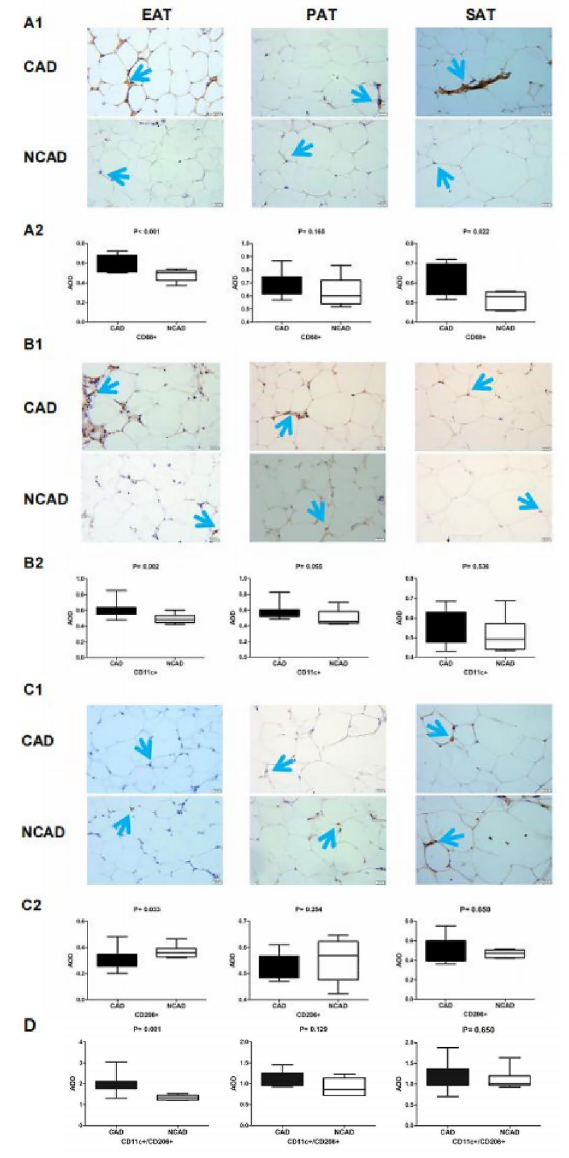
Figure 5. Immunohistochemistry detection of macrophage infiltration in adipose tissues in CAD (n = 11) and NCAD groups (n = 9). ( A1 ) Representative images of CD68+ expression in EAT, PAT and SAT. ( A2 ) Average Optical Density (AOD) of CD68+ in EAT, PAT and SAT between CAD and NCAD patients. ( B1 ) Representative images of CD11c+ expression in EAT, PAT and SAT. ( B2 ) AOD of CD11c+ in EAT, PAT and SAT. C1 , Representative images of CD206+ expression in EAT, PAT and SAT. ( C2 ) AOD of CD206+ in EAT, PAT and SAT. ( D ) Quantitative analyses of CD11c+/CD206+ in EAT, PAT and SAT. The Mann–Whitney U test was used to compare the relationship between the CAD and NCAD